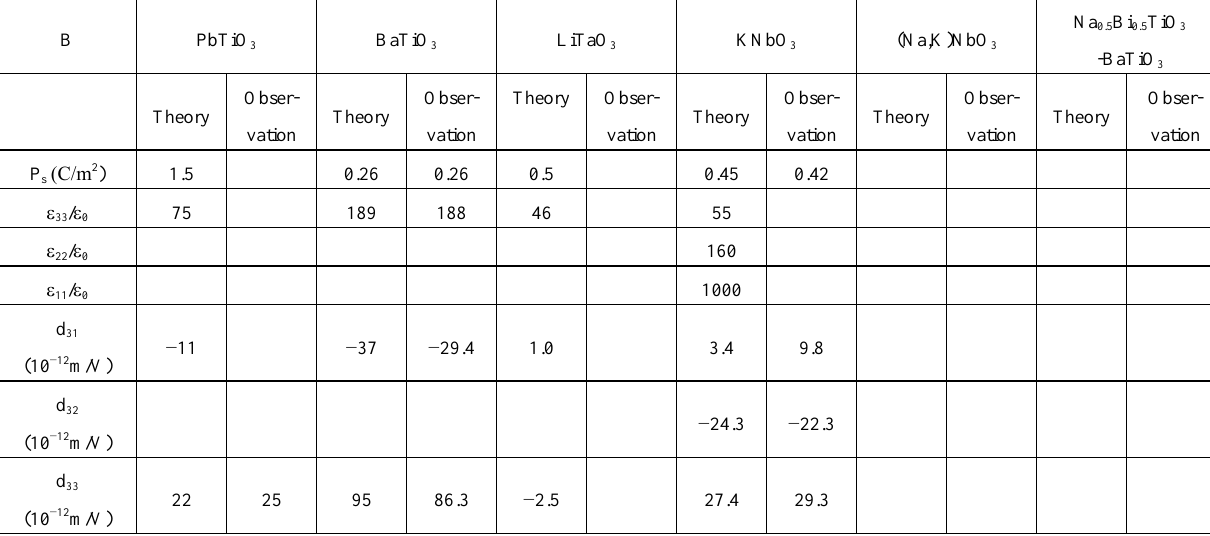
Table 3. Calculated dielectric and piezoelectric parameters (in SI